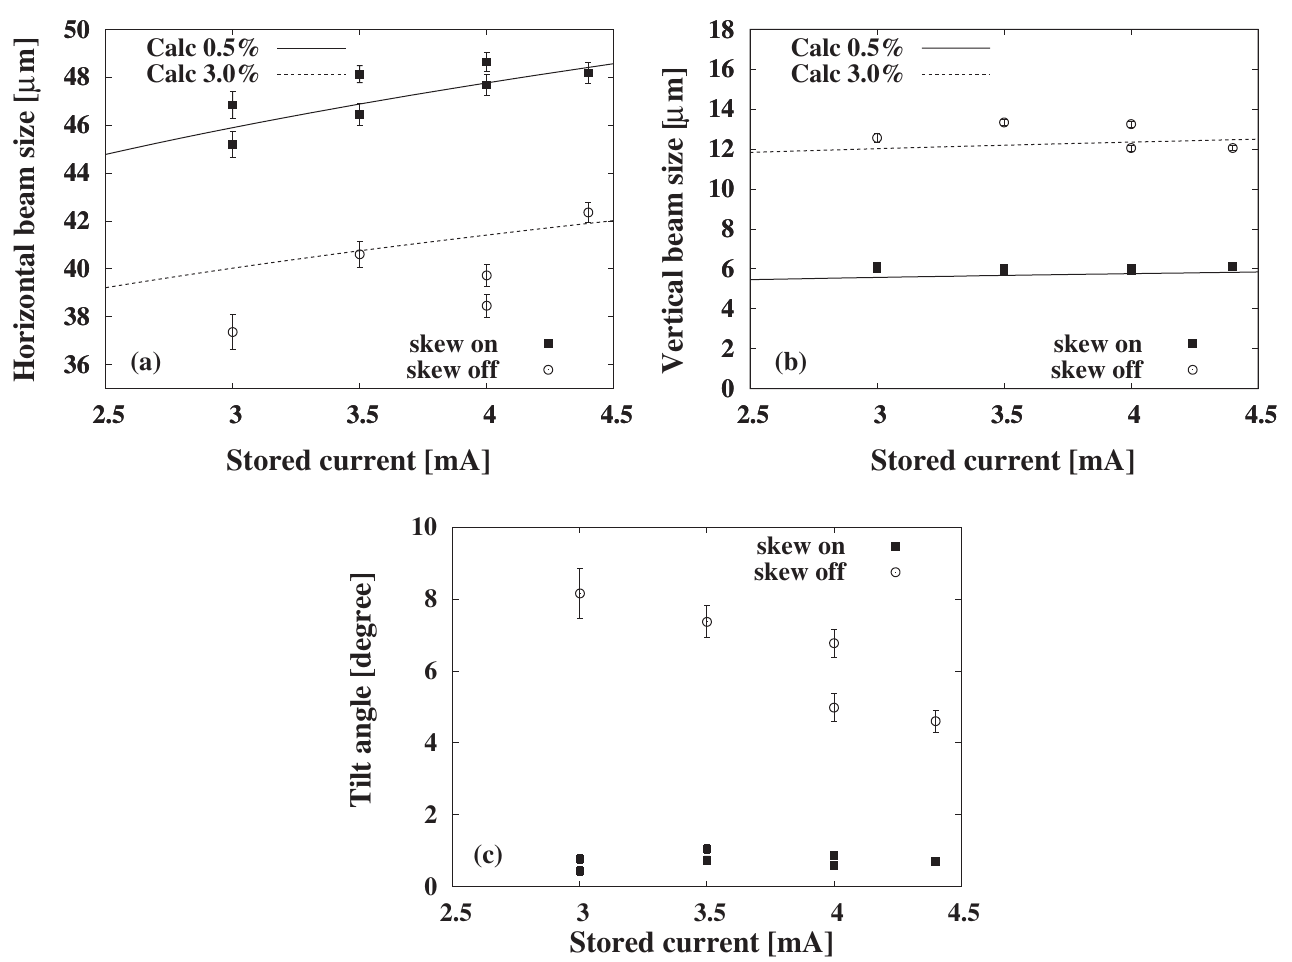
FIG. 21. Measured horizontal beam sizes (a) and vertical beam sizes (b) and tilt angles (c) vs stored current in the ATF damping ring. The solid boxes (open circles) show the data for the skew on (skew off) condition. The solid (dotted) lines of graph (a) and graph (b) are from calculations, assuming coupling ratios of 0 : 5% ( 3 : 0% ).